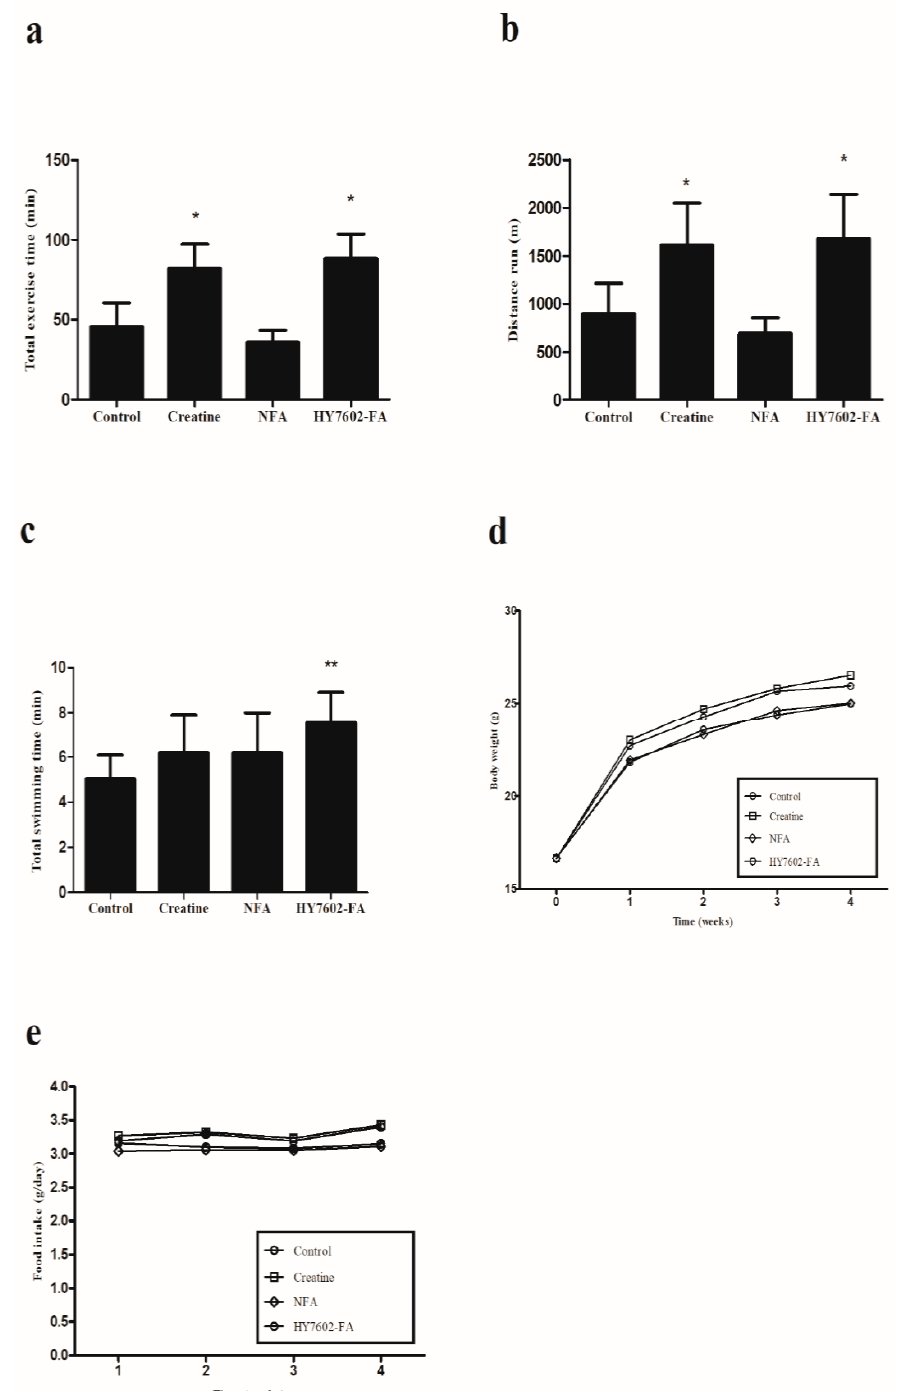
Figure 4. Effect of HY7602-FA on exercise endurance. Exercise capacity was measured based on total exercise time ( a ), running distance on a treadmill ( b ), or total swimming time ( c ). Data are expressed as the mean ± SD ( n = 9 mice per group), and asterisks indicate significant differences: * p < 0.05 and ** p < 0.01 vs. the control group. Changes in ( d ) body weight and ( e ) food intake over 4 weeks. NFA, non-fermented antler; FA, fermented antler.